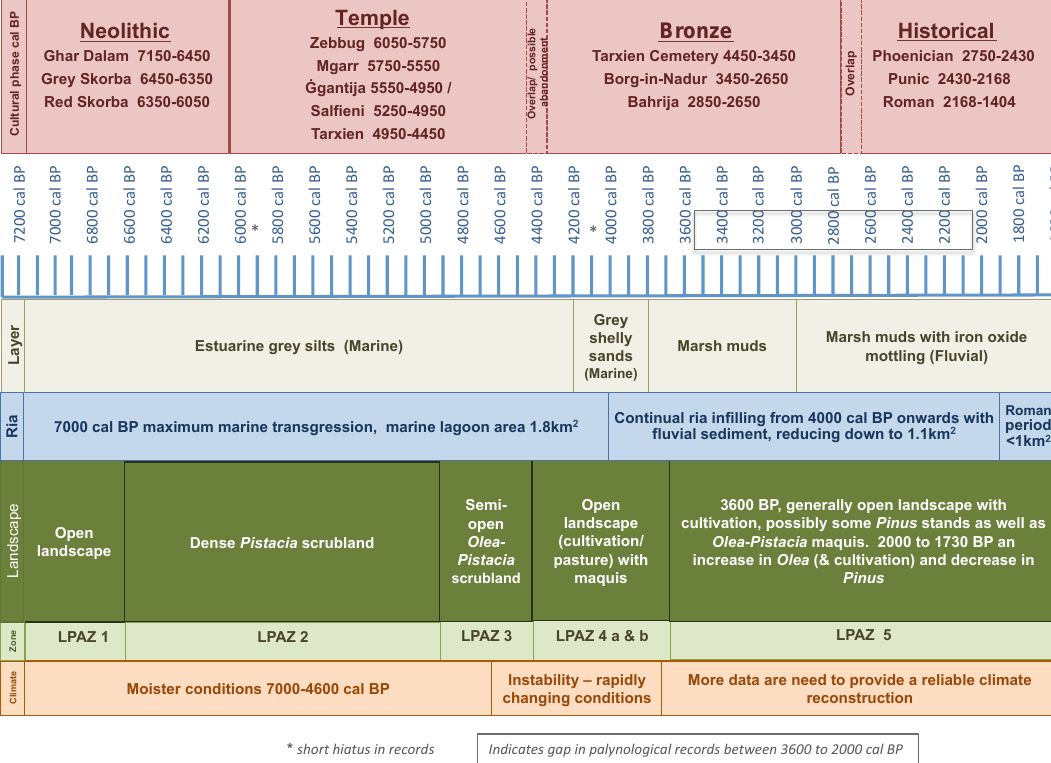
Figure 7. Synthesis of cultural phases, LPAZs (local pollen assemblage zones), sediment, vegetation dynamics, and climatic reconstruction: BM2 core,